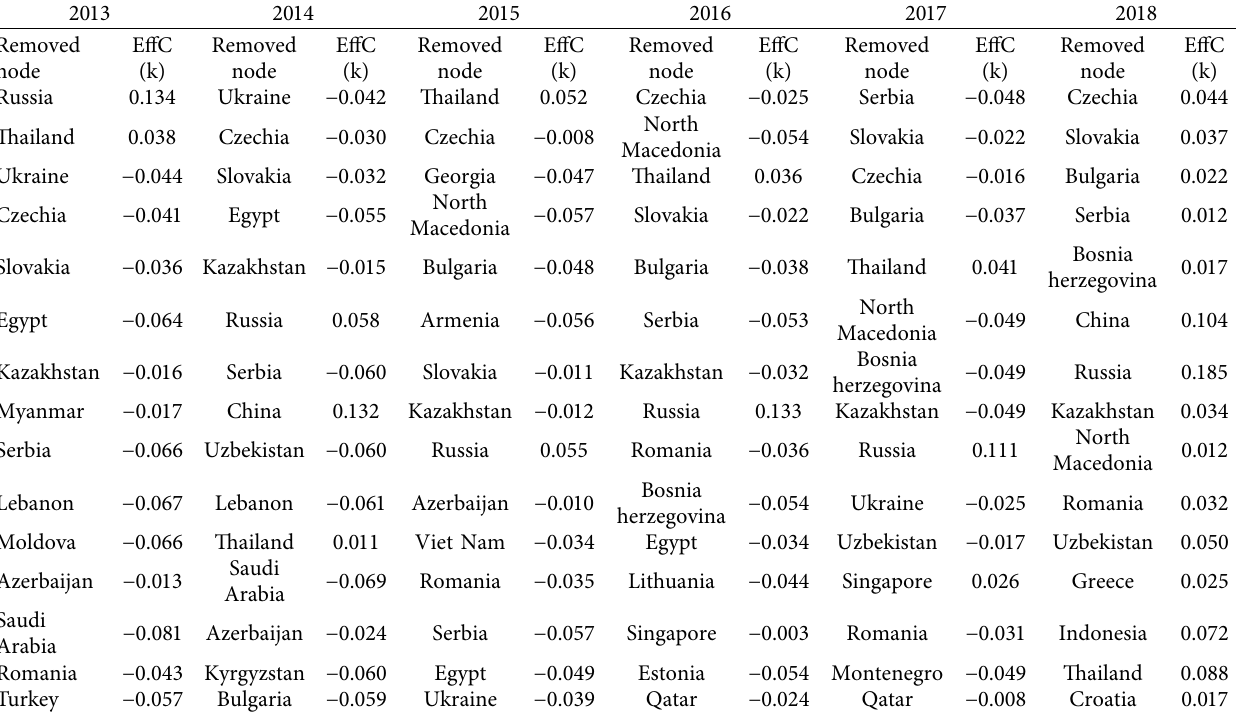
Table 2: Influences of removing the top nodes on the network efficiency when using the EVC